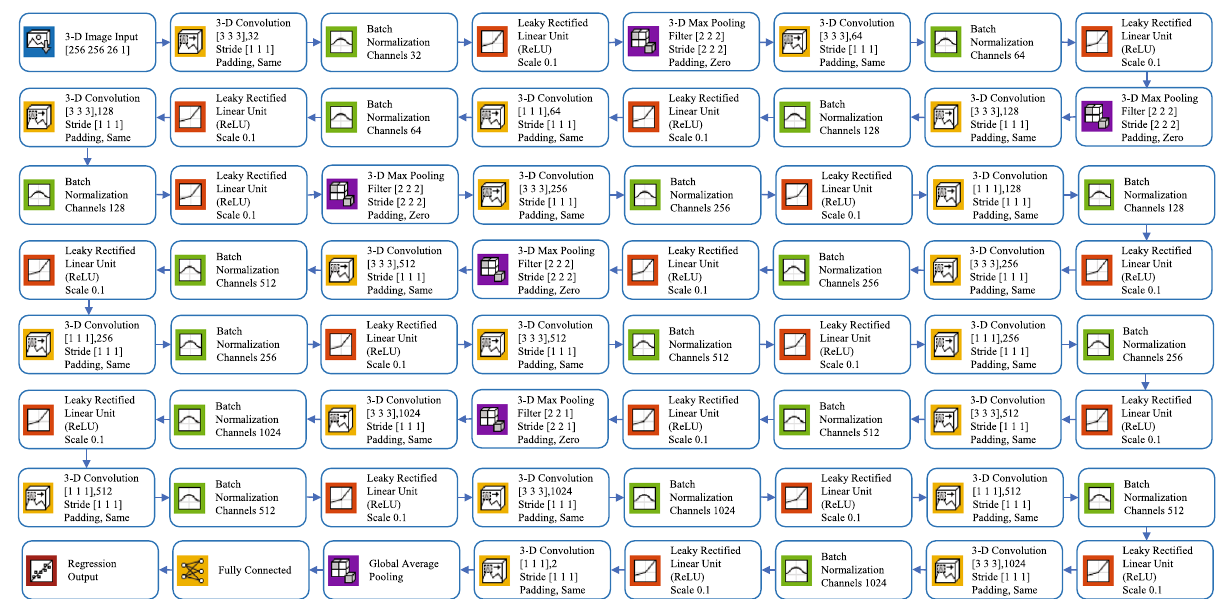
Figure 4. Architecture of the proposed 3D deep convolutional neural